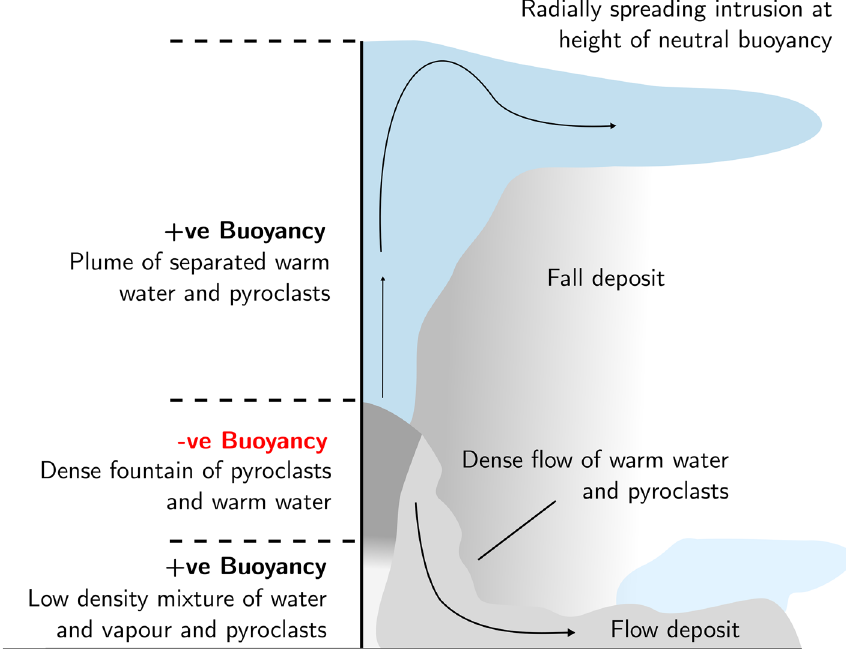
Figure 6. Schematic diagram illustrating the dynamics of deep-submarine explosive